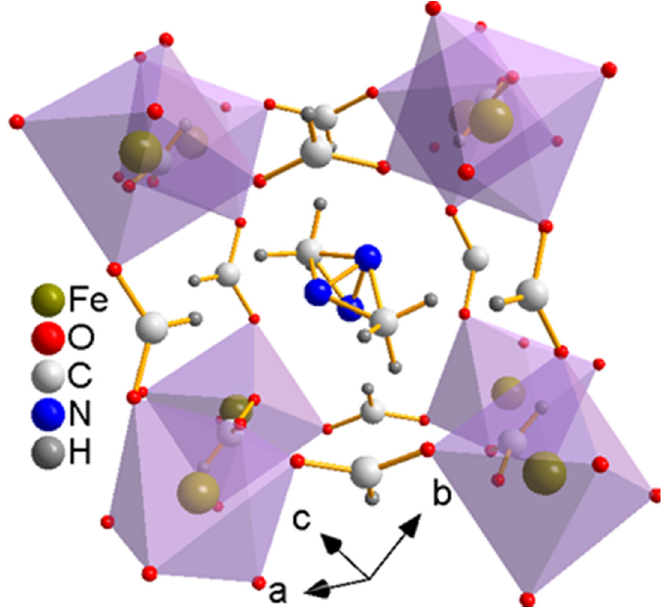
Figure 2. The rhombohedral R 3(cid:3364) c structure [17] of [(CH 3 ) 2 NH 2 ][Fe(HCOO) 3 ] at room temperature.